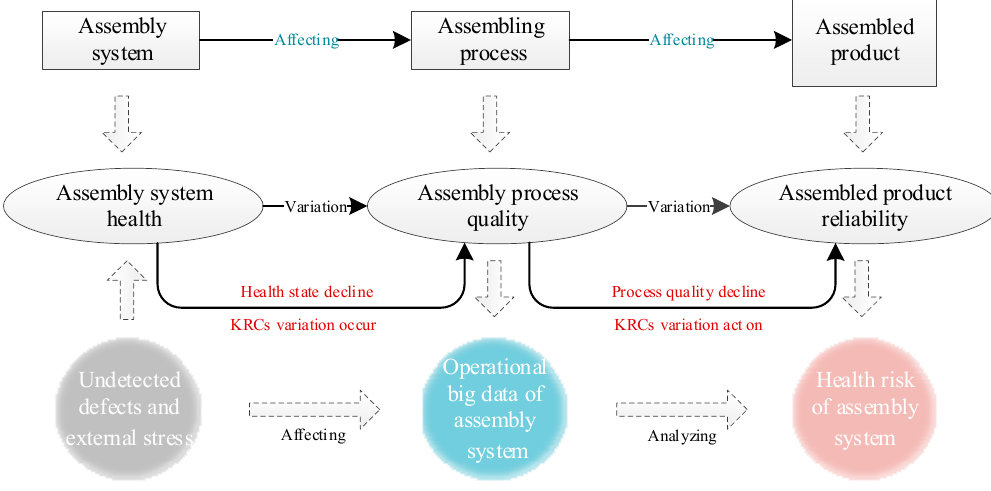
Figure 1. Formation mechanism of the assembly system health risk.